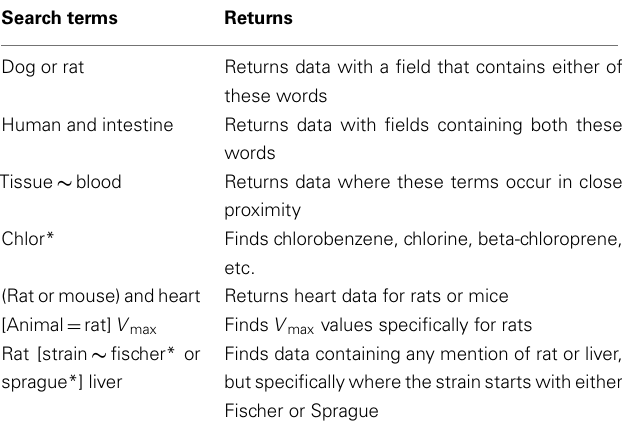
Table 1 | MEGen: PBPK database search